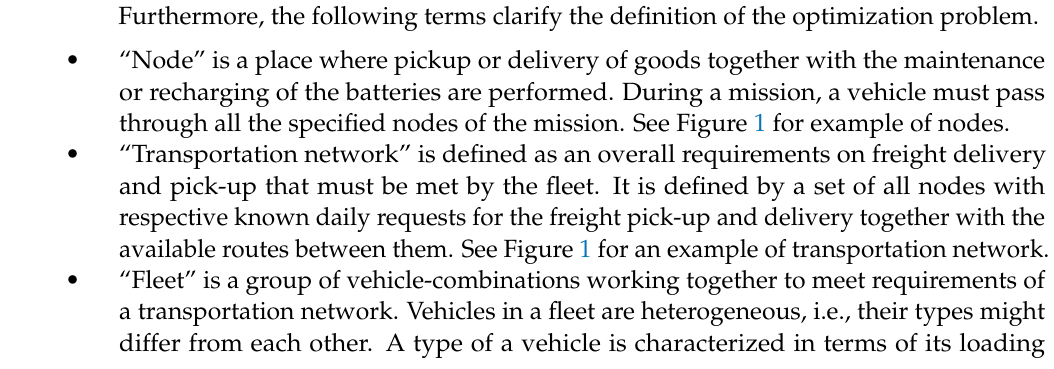
Table 1. General vehicle-transportation optimization problem, which includes both transportation- and vehicle-design variables. Decision (Design) Variables Missions, routes within missions, types and numbers of vehicles utilized in each mission, number of trips performed by each vehicle in each mission, charging power of each vehicle at each node, loading–unloading scheme of each vehicle at each